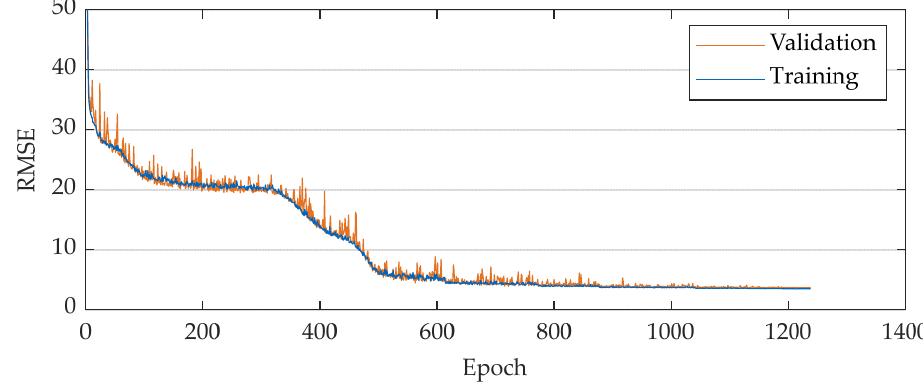
Figure 8. Training and validation loss of the BPNN during training for Use Case 1. Prediction on the test data (725 data points) set were performed to verify further the ability of the models to generate accurate predictions based on unused data. The RMSE and the R ‐ squared values for each model for the test dataset are listed in Table 5. The computation time required for the inference is provided as well. Table 5. Results of the models on the test set for Use Case 1. PR